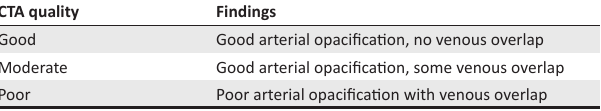
TABLE 2: Computed tomography angiography quality grading criteria used by both radiologists.